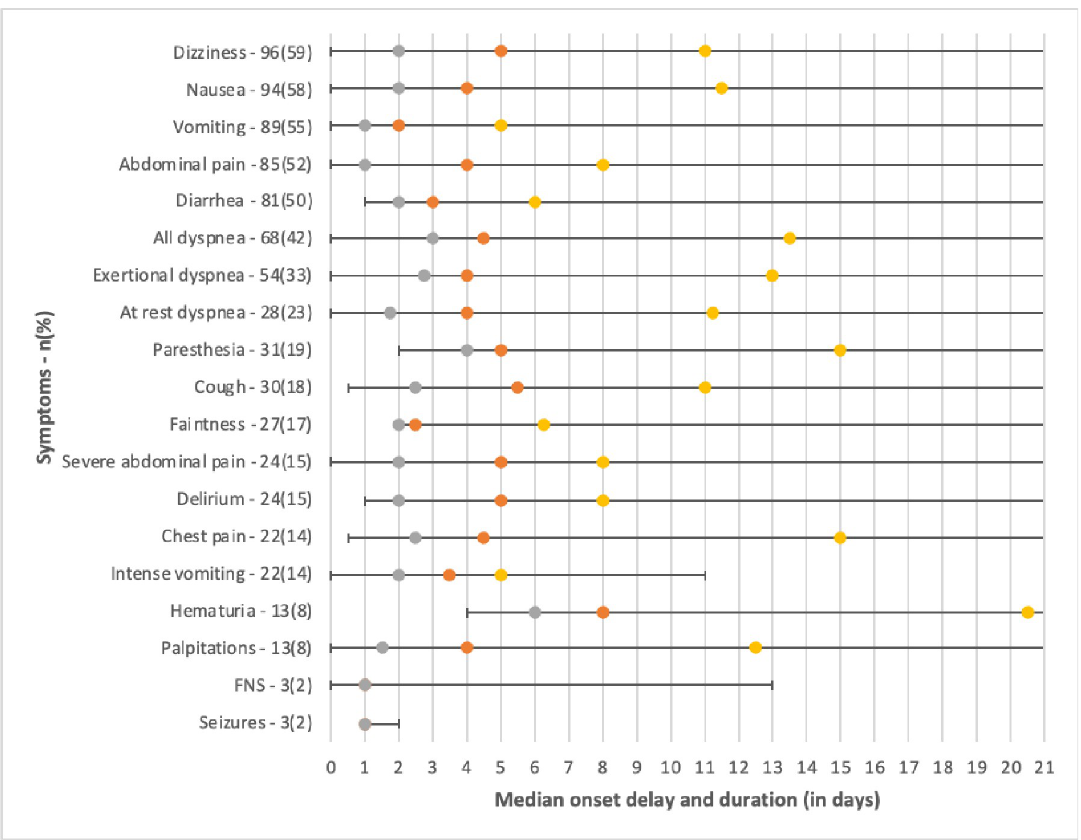
(Table 1). The mean length of stay was longer in cases of SD than in cases of non-SD (p = 0.013).